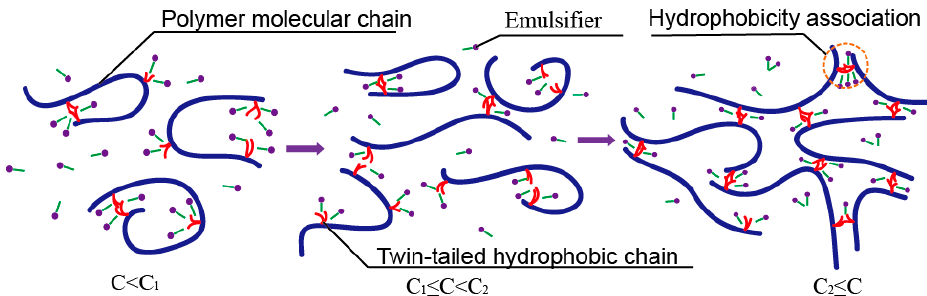
Figure 6. Molecular chain morphology of polymers containing hydrophobic monomers in aqueous solution varies with concentration.